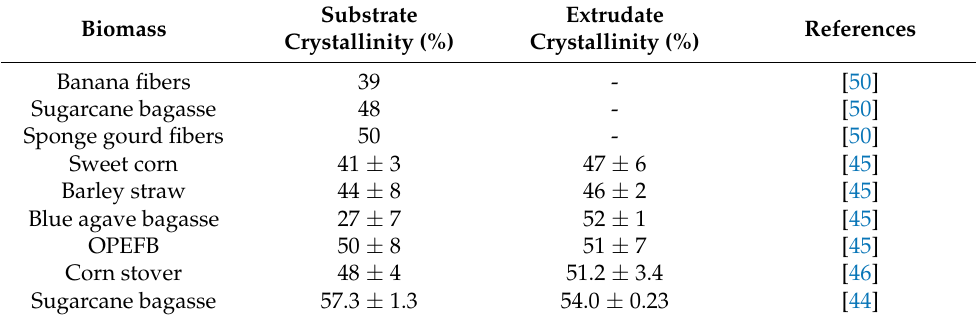
Table 2. Crystallinity